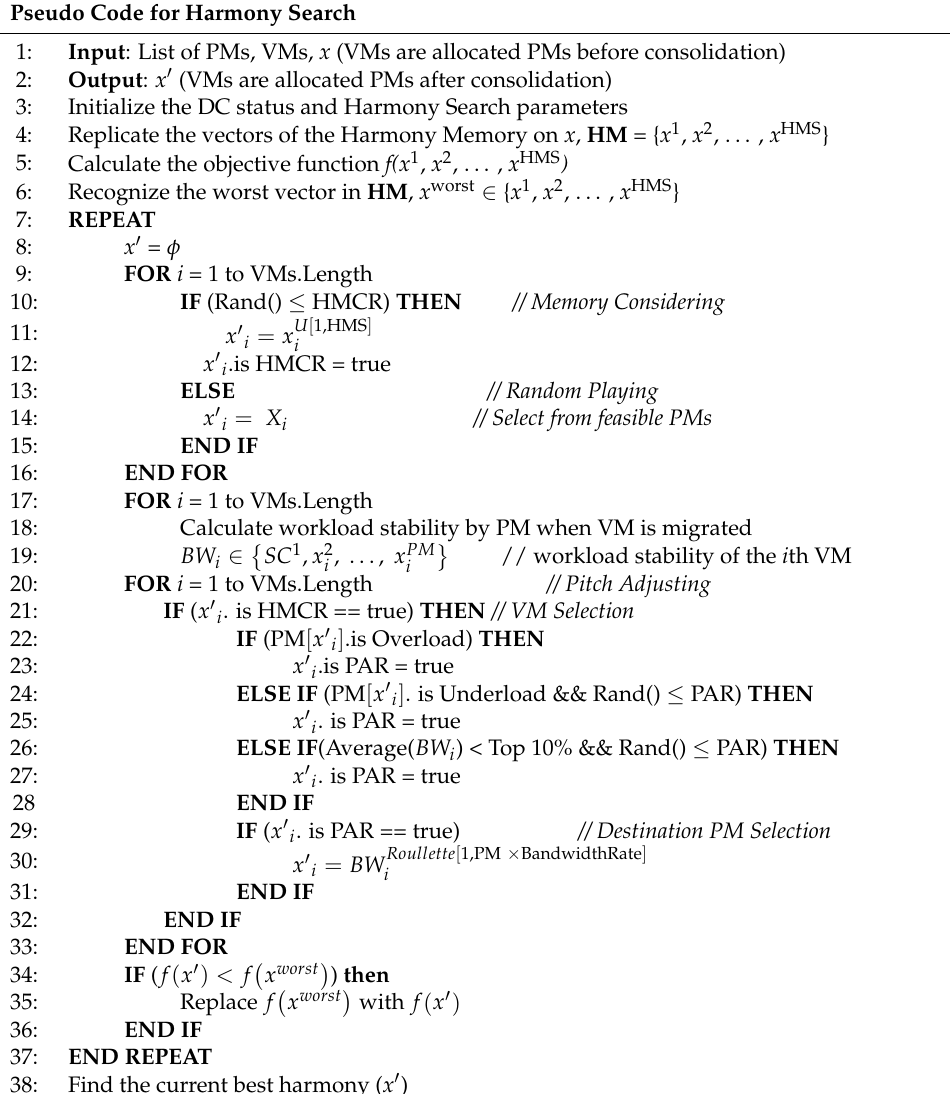
Table 1. Pseudo code for harmony search (HS) in VM consolidation framework. Pseudo Code for Harmony